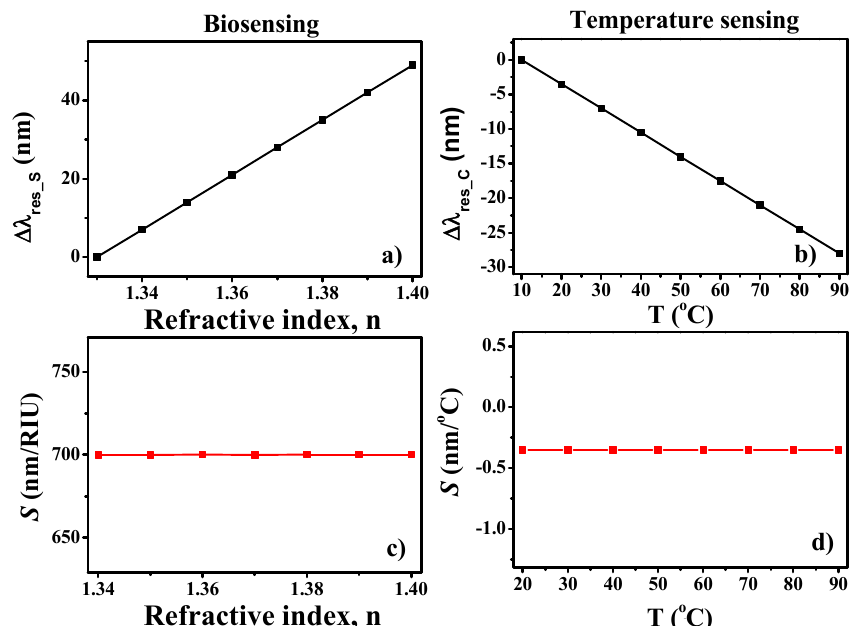
Figure 9. Spectral characteristics: ( a ) ∆λ res_S versus refractive index of the analytes, ( b ) ∆λ res_C versus temperature, ( c ) sensitivity versus refractive index of the analytes, and ( d ) sensitivity versus temperature.